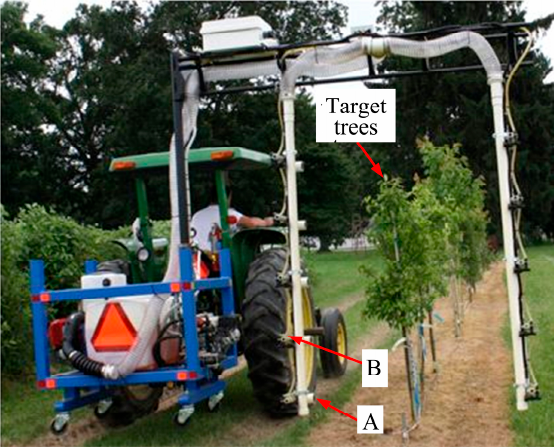
Figure 13. The real-time variable-rate sprayer and its components ( A —ultrasonic sensor, B —spray nozzle with PWM solenoid valve) [111].